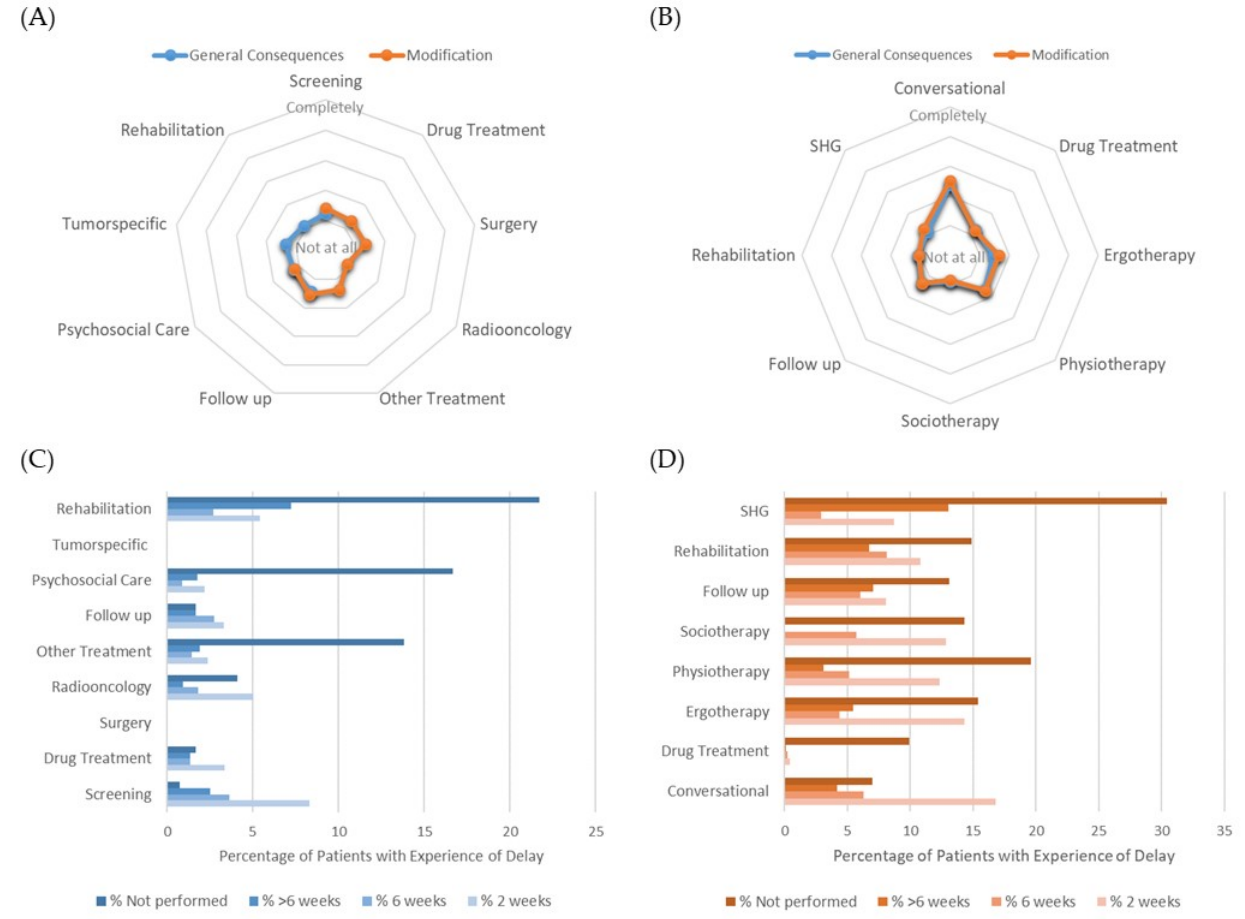
Figure 3. Perception of generally required treatment modifications and consequences for their own clinical care by patients in ( A ) oncology and ( B ) psychiatry; patients’ acknowledgement of treatment delay in ( C ) oncology and ( D ) psychiatry.